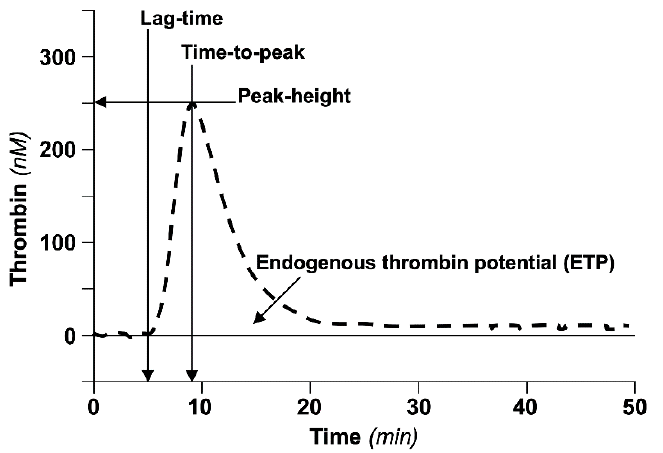
Figure 2. Schematic representation of the thrombin generation curve (thrombogram) with relevant parameters.